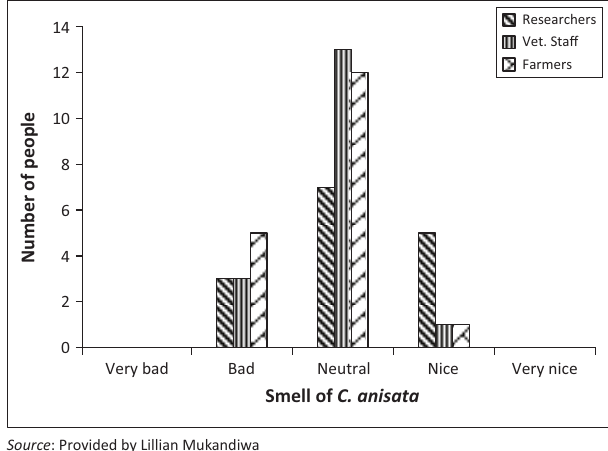
FIGURE 5: Summary of results on the sensory evaluation of the Clausena anisata